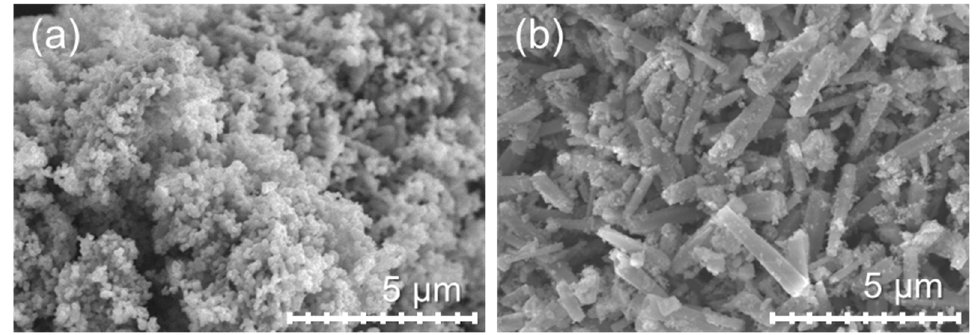
Figure 3. SEM micrographs of ZnO prepared from ZA and ZN precursors: ( a ) ZnO ‐ A and ( b ) ZnO ‐